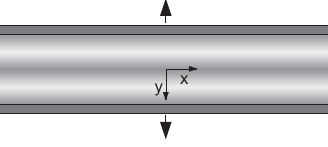
Figure 4: Load case 2 illustration